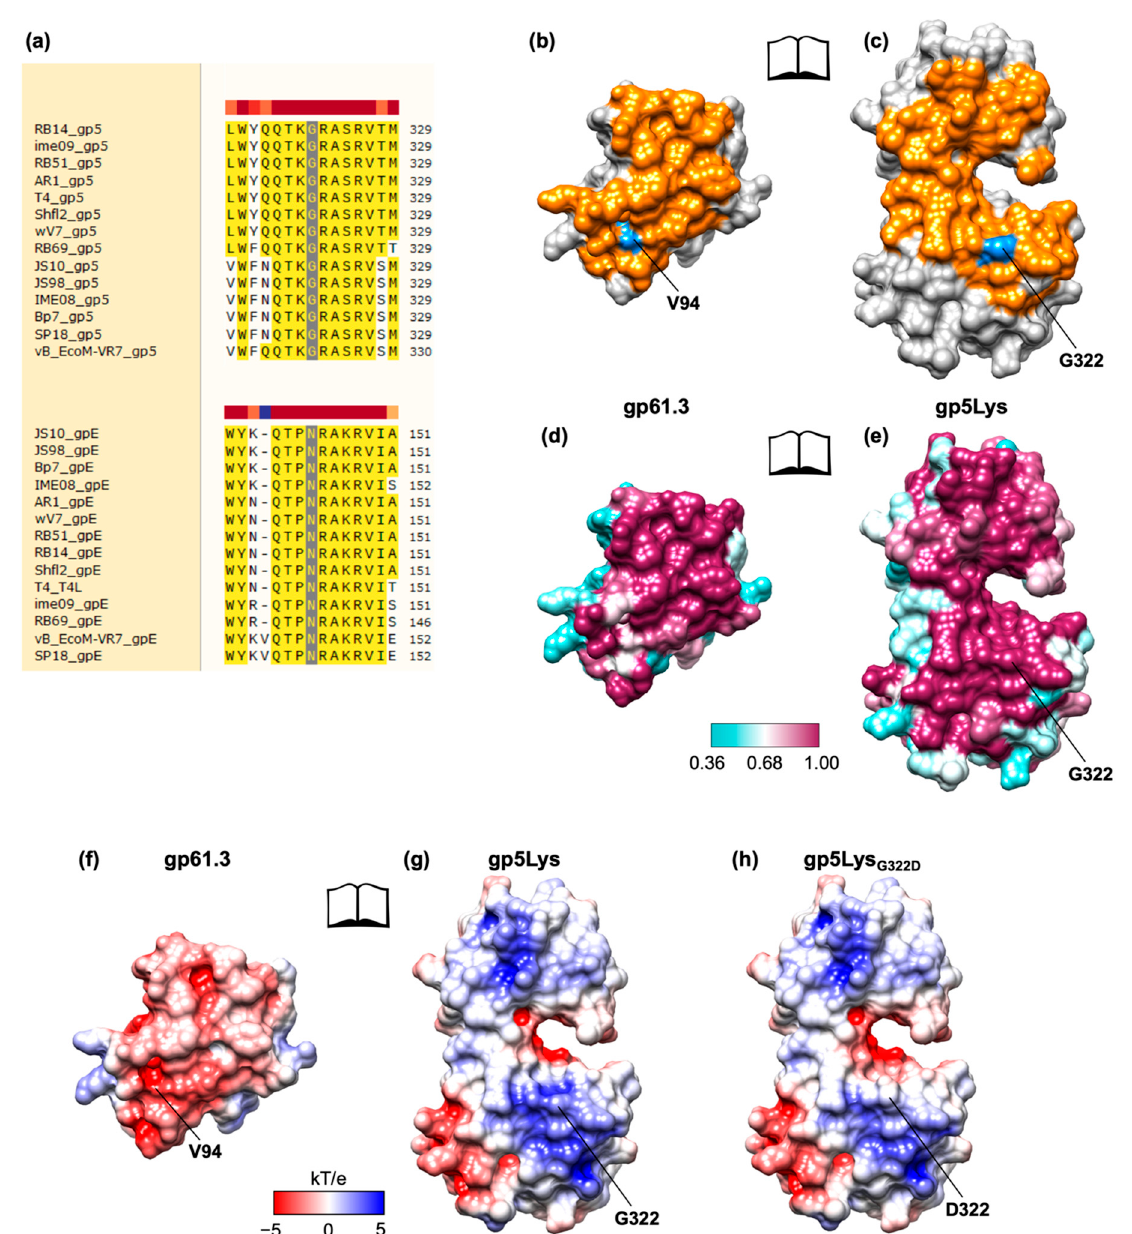
Figure 9. Properties of the gp61.3-gp5Lys interface. ( a ) A fragment of sequence alignment of gp5 proteins from T4-like phages near residue G322 and the same for T4L orthologs (labeled gpE here) around the equivalent residue N144. The G322 and N144 columns are marked with a gray color. ( b ) and ( c ): the molecular surface of the gp61.3-gp5Lys interface in an “open book” representation. The interacting residues are colored orange. G322 of gp5Lys and its most proximal residue of gp61.3 (V94) in the gp61.3-gp5Lys complex are colored dodger blue. ( d ) and ( e ): sequence conservation is mapped on the molecular surface of the gp61.3 and gp5Lys interface (an open book representation). The color bar gives the degree of conservation with 1.00 corresponding to absolute conservation. ( f ) and ( g ): the electrostatic properties of the gp61.3-gp5Lys interface (an open book representation). ( h ) The electrostatic properties of gp5 G322D mutant. The electrostatic potential was calculated using ABPS